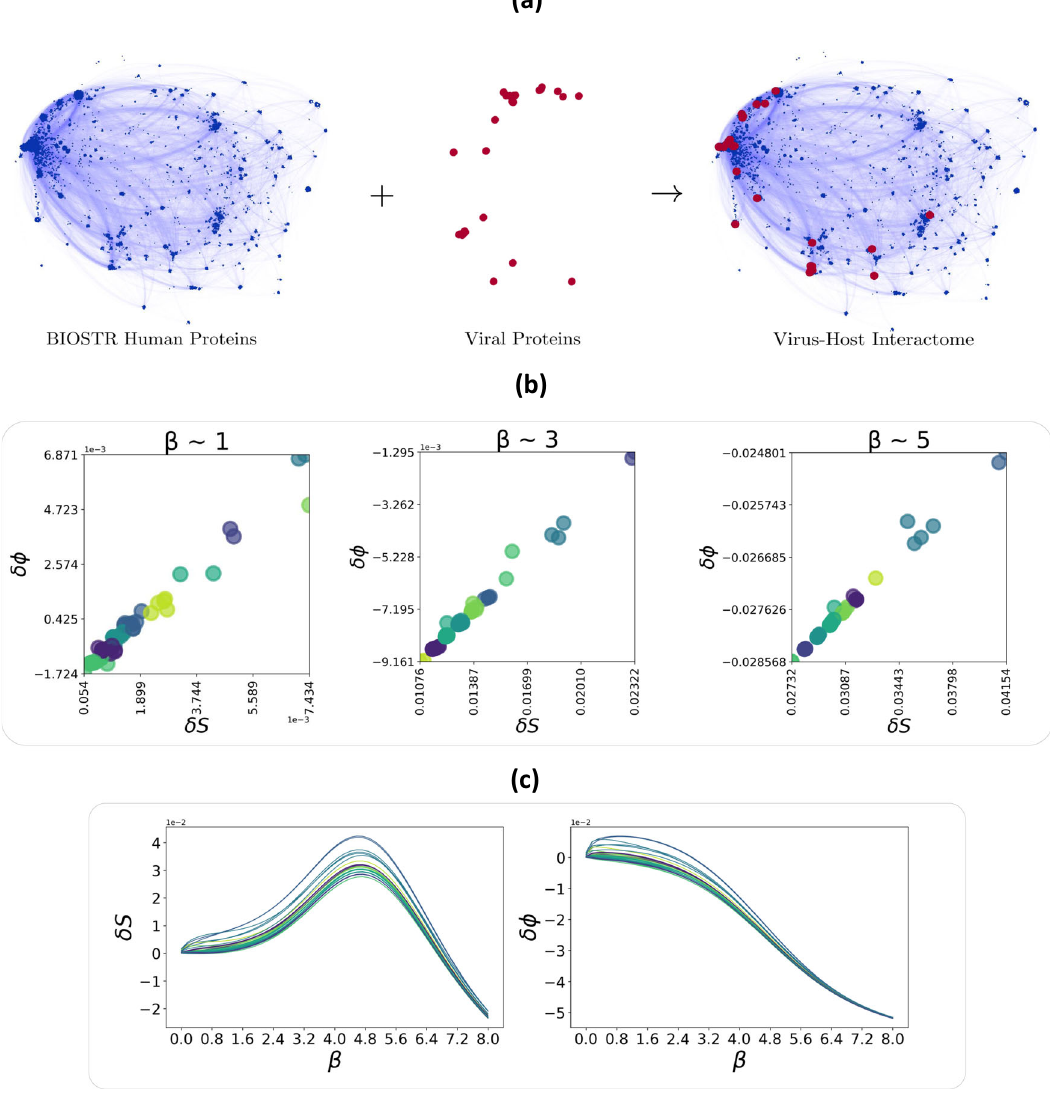
Fig. 4 Perturbation analysis of the virus – host interactome. a The BIOSTR human interactome G is targeted by viral proteins, considered as perturbations δ G , to build the virus – human interactome G 0 . Here, the SARS-CoV-2 interactome is shown, while excluding the 10% human proteins with the highest degree, for clarity. The interdependence is re fl ected in the macroscopic functions of the network, perturbing the thermodynamic-like features, at different temporal scales for signal propagation characterized by β . The perturbations of the macroscopic properties of the human protein – protein interaction network ( b ), re fl ected in the von Neumann entropy δ S ð β ; G 0 Þ and the Massieu function δ ϕ ð β ; G 0 Þ are shown, where each dot corresponds to a speci fi c virus and the color of the dotts shows their clustering (see the text). More speci fi cally, the von Neumann entropy and Massieu function perturbations caused by each virus, are used as features de fi ning a two-dimensional space, k-means algorithm is used to cluster the viruses at different scales corresponding to different temporal scales β ≈ 1, 3, 5. The trajectories ( c ) indicate that the perturbation caused by each virus change with β , leading to possibly different clustering at different temporal scales. The color of each trajectory in b is set by the clustering plot given at β ≈ 3 ( b